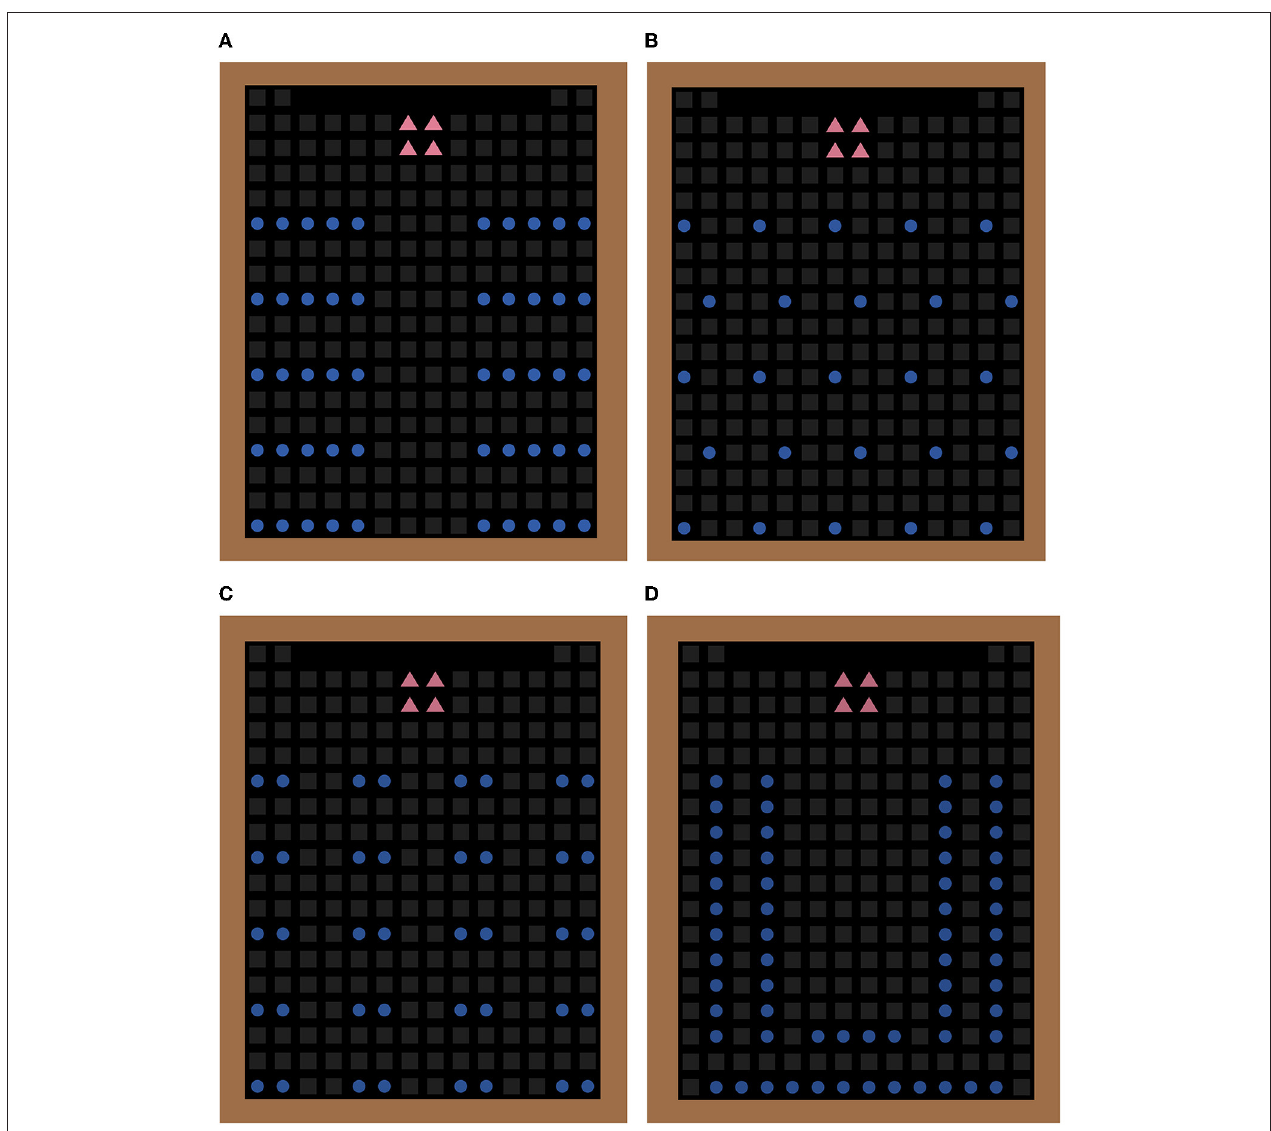
FIGURE 1 | Figure representations of: (A) Two-Block Layout, (B) One-Seat Apart Layout, (C) Pairwise Layout, and (D) Double Horseshoe Layout. Each blue circular node represents a seat node that can be occupied by a student while the gray square nodes indicate aisle nodes. The four pink triangular nodes indicate the area occupied by the